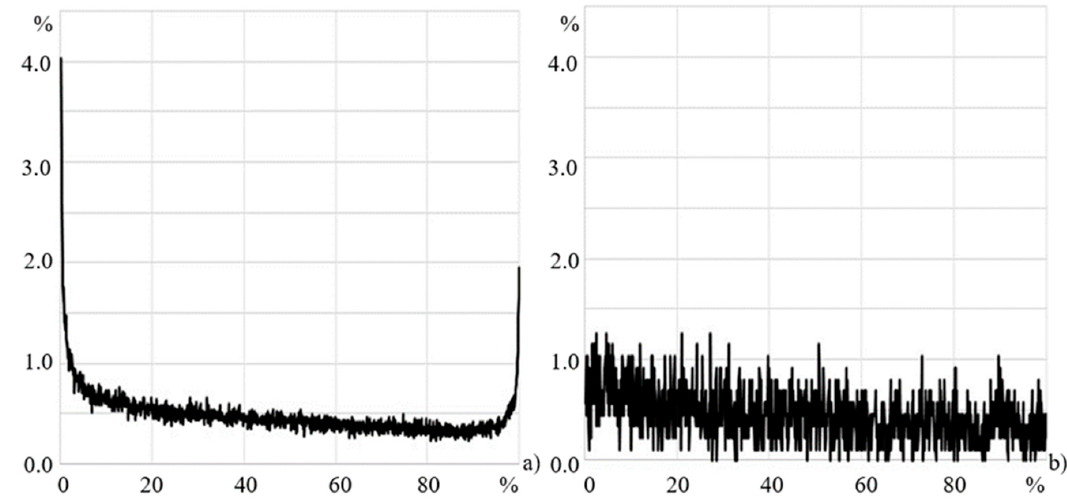
Figure 7. Recurrences in state of charge (SOC) for ( a ) 3-min; and ( b ) 60-min temporal resolution.